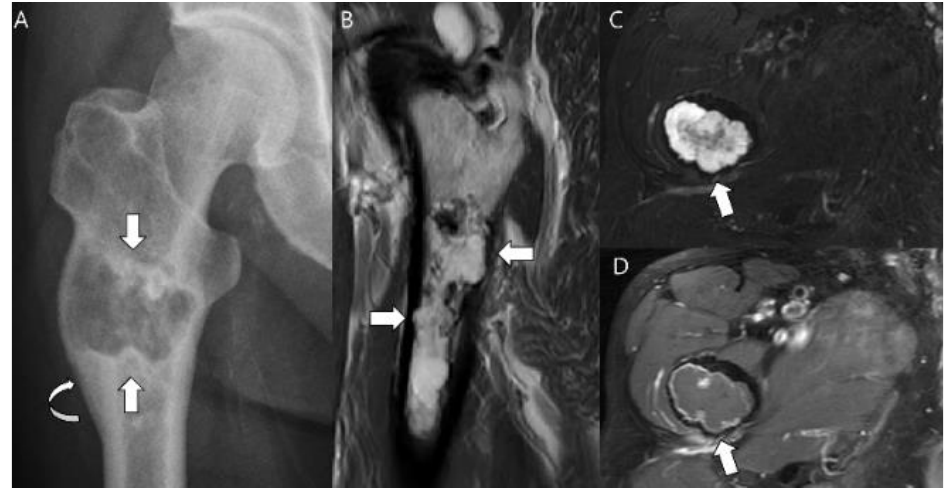
Figure 5. Chondrosarcoma grade 2 of the proximal femur in a 71-year-old man. ( A ) Anteroposterior radiograph reveals a lytic lesion in the proximal femur (arrows) resulting in cortical thickening and periosteal reaction (curved arrow). ( B ) Sagittal T2-weighted image shows a markedly high-signal lesion with deep endosteal scalloping (arrows). ( C ) Axial T2-weighted image with fat suppression and ( D ) axial T1-weighted enhanced image demonstrates a lobulated chondroid tumor with focal bone expansion (arrows).